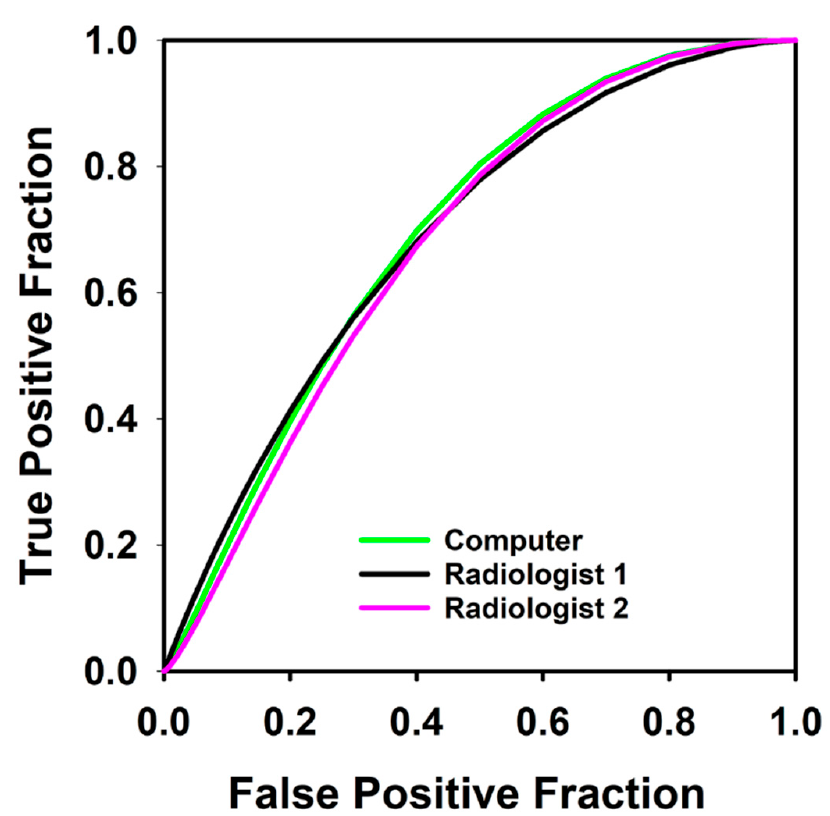
Figure 4. Receiver operating characteristic curves for predicting which patients would not achieve disease free survival at 1 year using combined response index of blood flow and percent volume change calculated from contours by computer, Radiologist 1, and Radiologist 2 in 36 pre- and post-induction therapy tumors. AUC for the computer, Radiologist 1 and Radiologist 2 were 0.69, 0.71 and 0.68